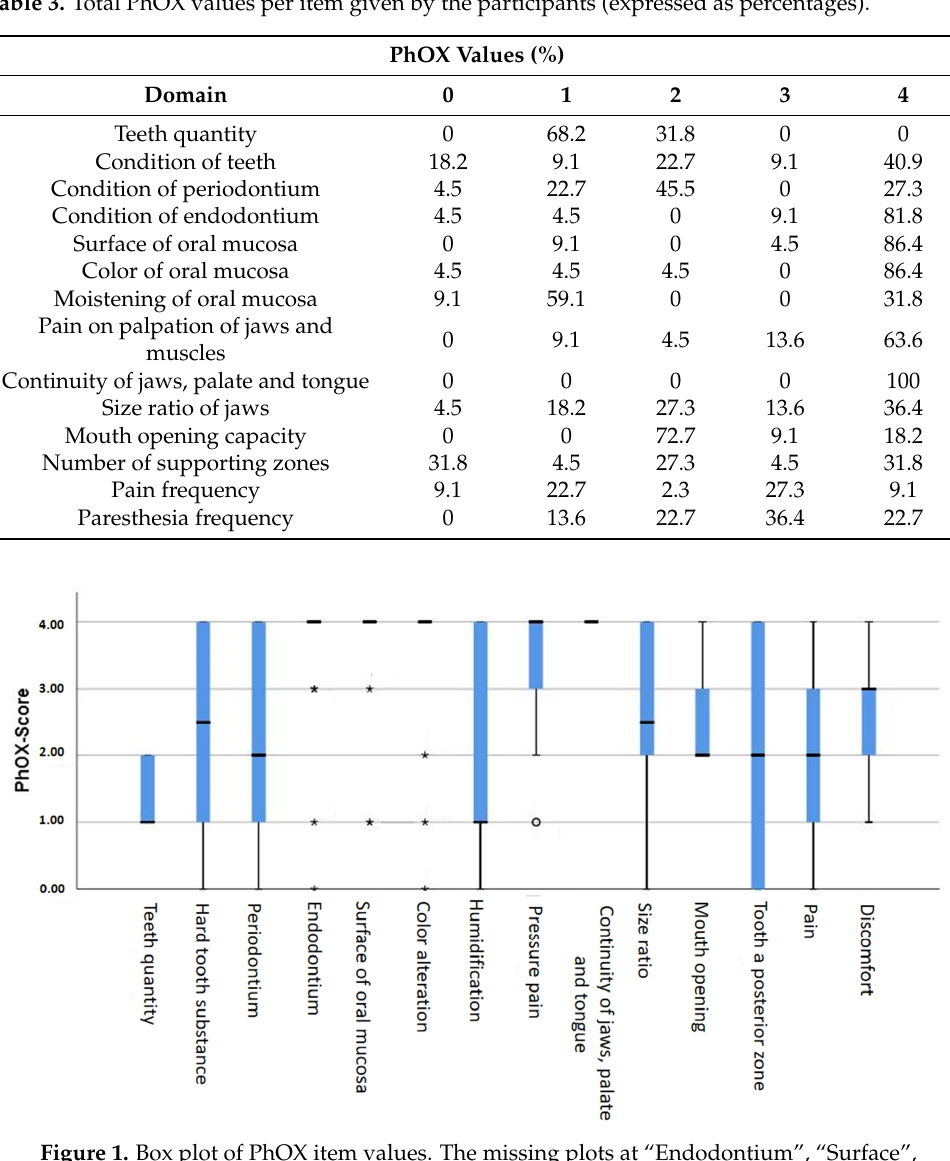
Figure 1. Box plot of PhOX item values. The missing plots at “Endodontium”, “Surface”, “Color alteration” and “Continuity” represent concentrations of samples with the same y-value (4.0). The asterisks and ball marks indicate outliers.